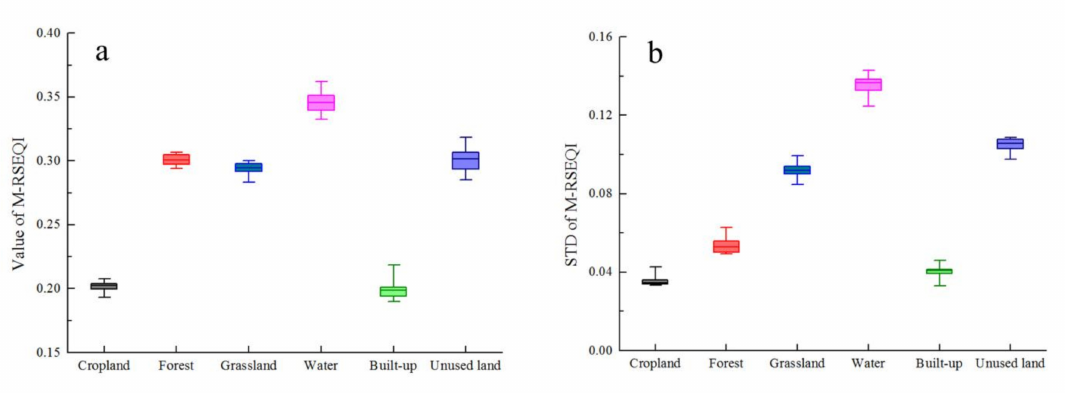
Figure 6. The mean ( a ) and standard deviation ( b ) of the M-RSEQI in different ecosystems in China from 2000 to 2013.